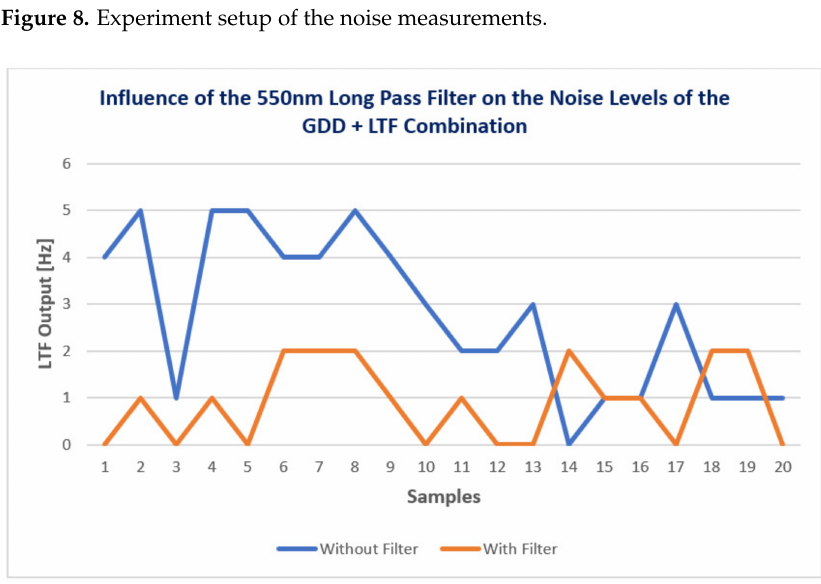
Figure 9. The influence of the 550 nm long pass filter on the noise levels of the GDD + LTF pixel.